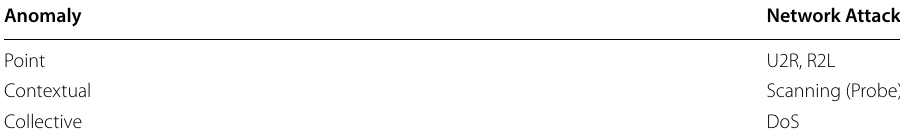
Table 1 Examples of Network Anomalies Types [5]